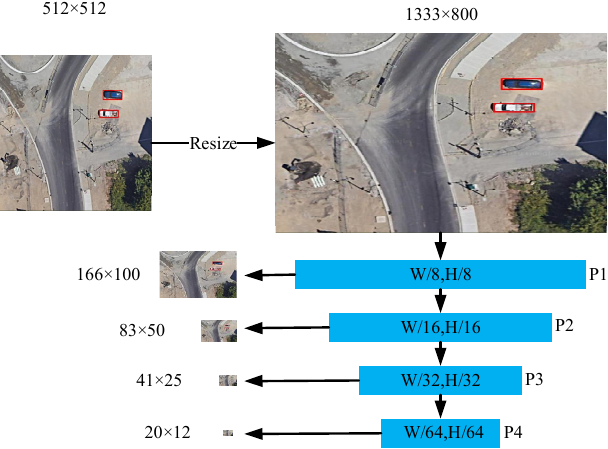
Figure 4. Scale change of feature pyramid network (FPN) after image resize.